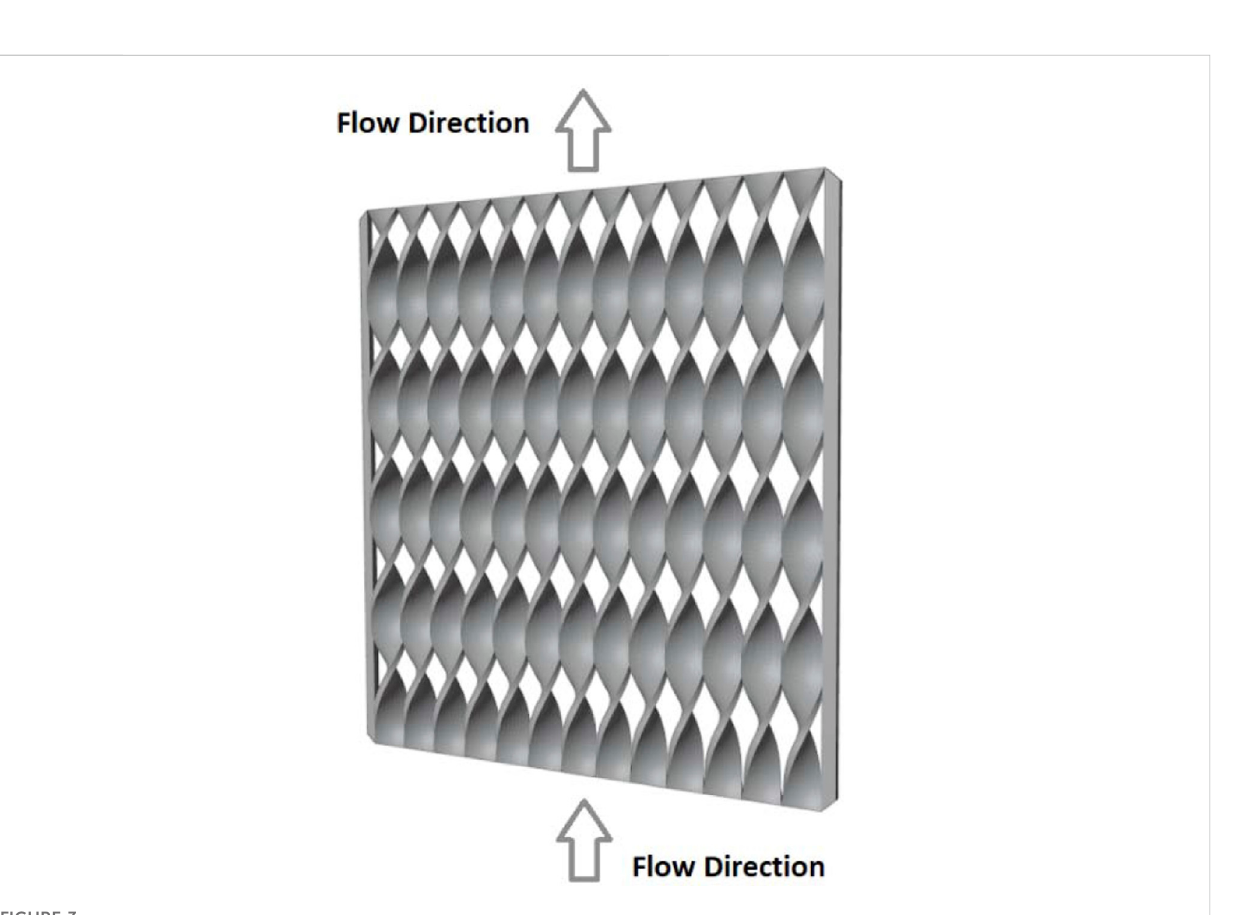
FIGURE 3 The geometry of the static mixers. Based on data from Percin et al.